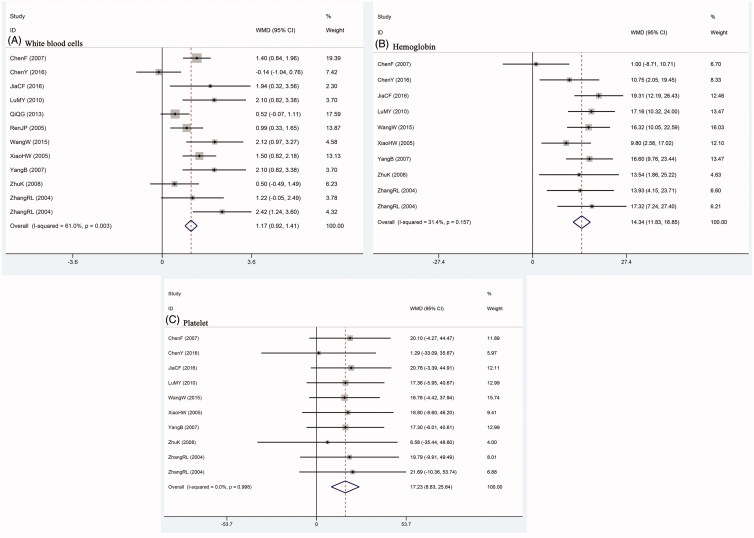
Comparison of blood system between SFI intervention and control group. A: white blood cells; B: haemoglobin; C: platelet.